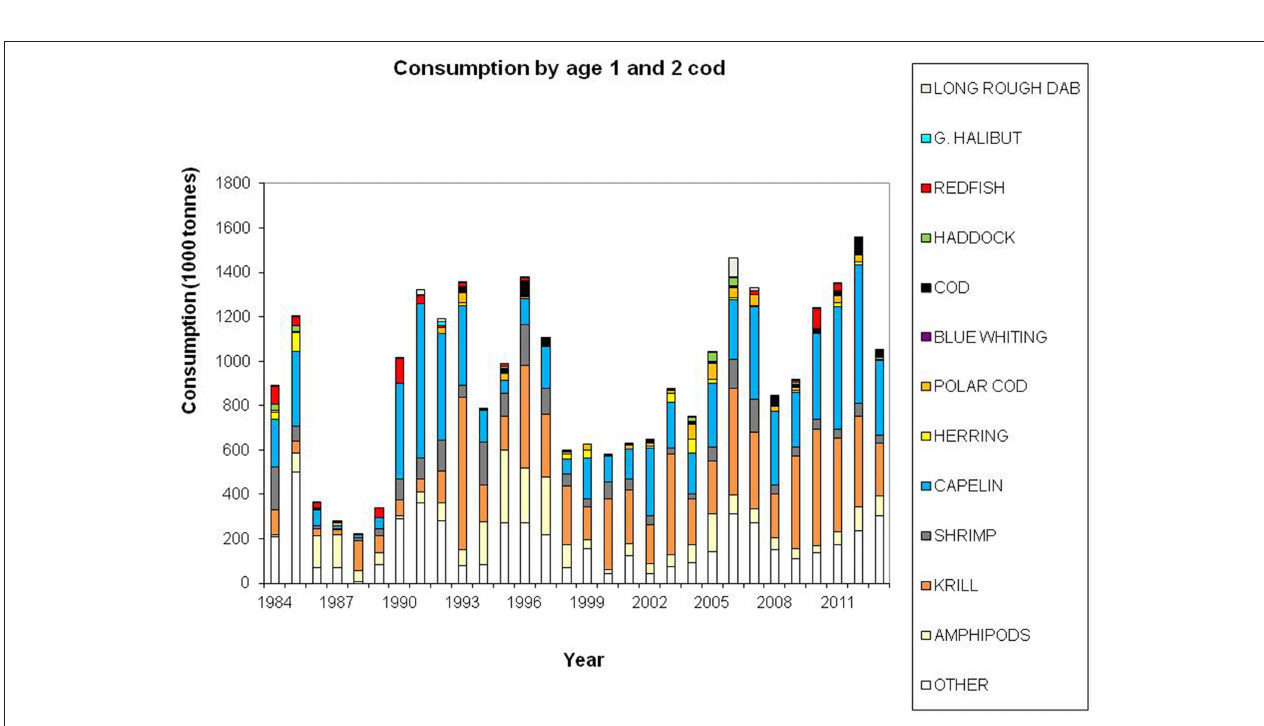
FIGURE 7 | Total consumption by age 1–2 cod based on calculations presented in ICES (2014a), using the method described by Bogstad and Mehl (1997). These calculations are